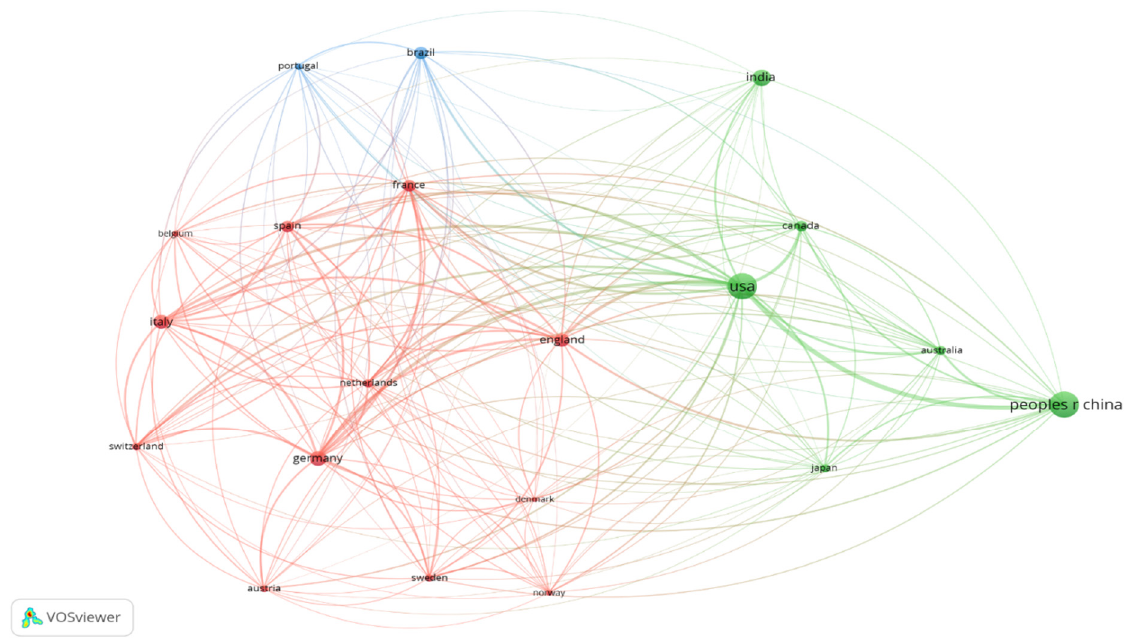
Figure 10. Research collaboration network amongst the top 20 countries in terms co-authored documents (2016–2018).